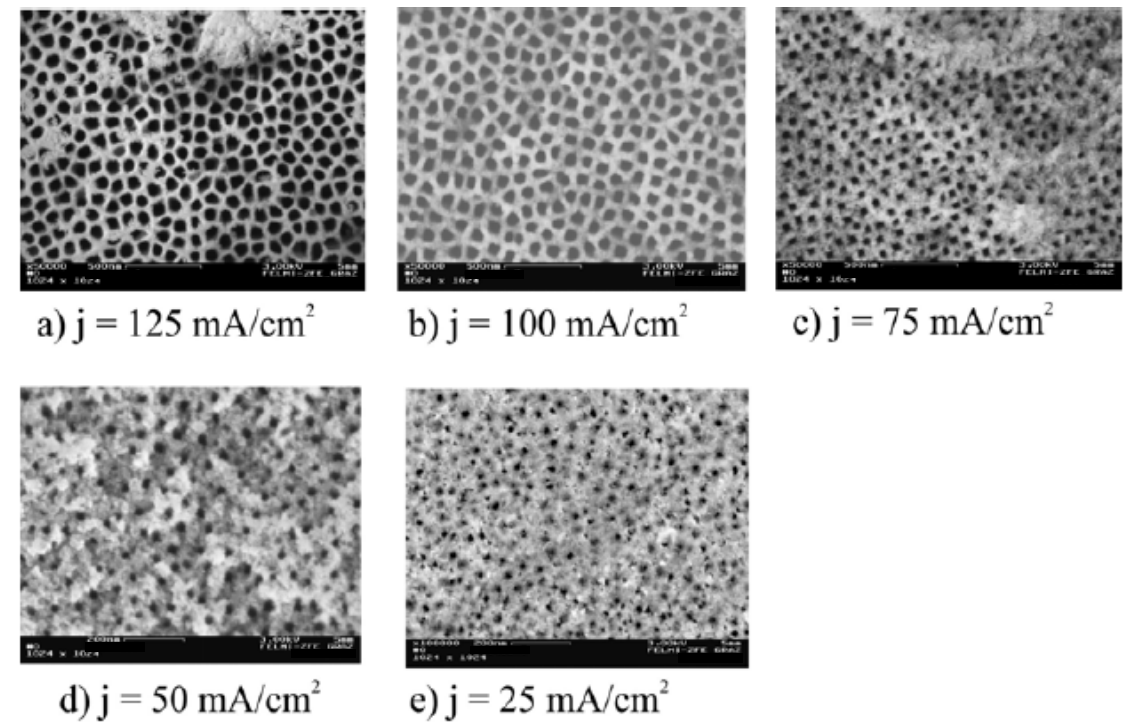
Figure 7. Morphology of the porous silicon template varied by the applied current density [83]. As starting material a (100) n + -Si wafer is used. (a) Pore-diameter ~95 nm ± 10 nm, pore-distance ~45 nm; (b) Pore-diameter ~60 nm ± 8 nm, pore-distance ~50 nm; (c) Pore- diameter ~45 nm ± 10 nm, pore-distance ~55 nm; (d) Pore-diameter ~25 nm, pore-distance ~60 nm; (e) random pore size